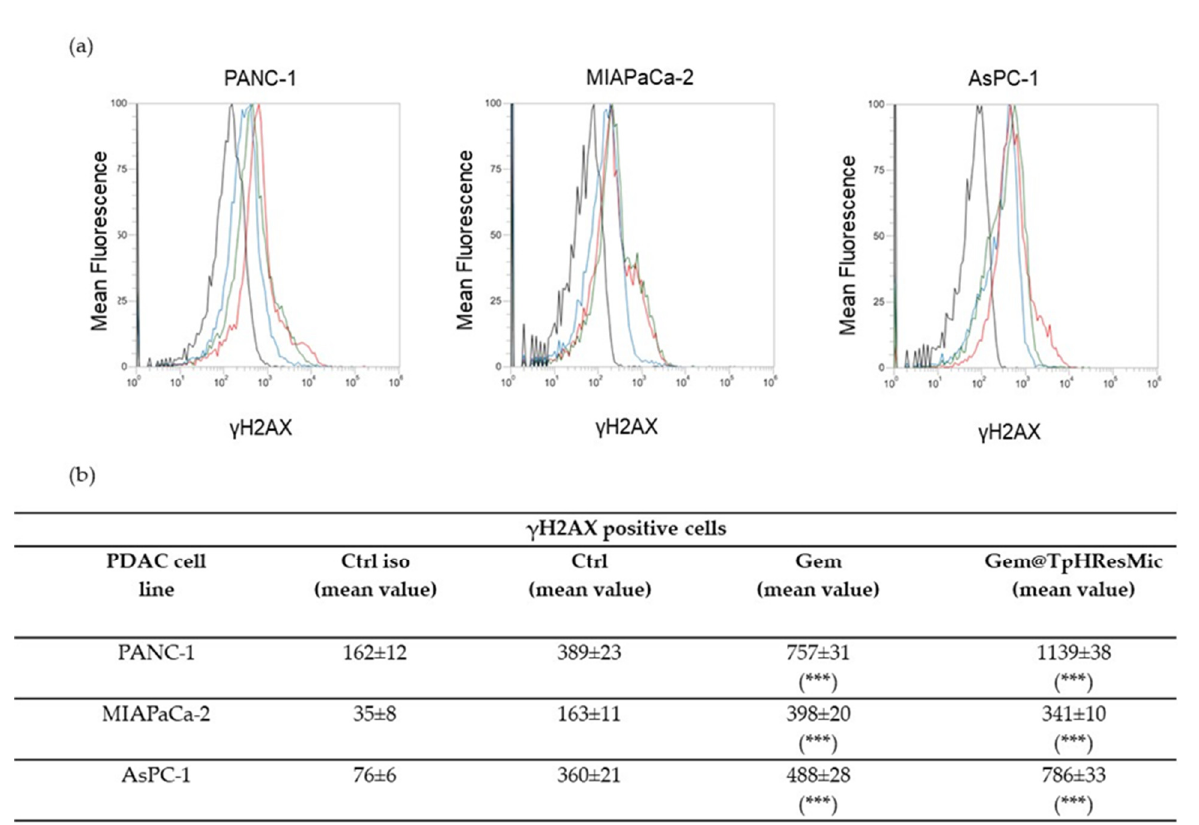
Figure 12. ( a ) Representative FCM histograms showing the γ H2AX positive PDAC cells after treat- ment for 24 h at pH 6.8 with free Gem or Gem@TpHResMic (black line—isotype ctrl; blue line—ctrl; green line—Gem; red line—Gem@TpHResMic). ( b ) Mean values of γ H2AX-positive PDAC cells in all treatment conditions are reported as the mean ± SD of the three independent experiments (*** p < 0.001 as respect to untreated cells; Ctrl—untreated cells).